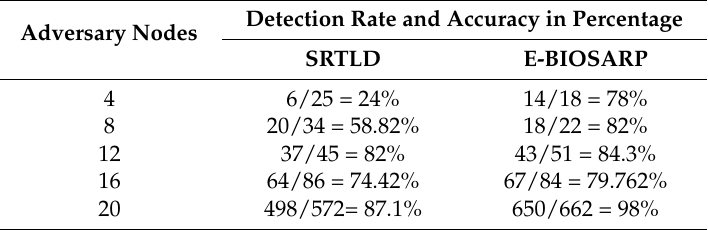
Table 5. Influence of malicious nodes on network performance in terms of security.